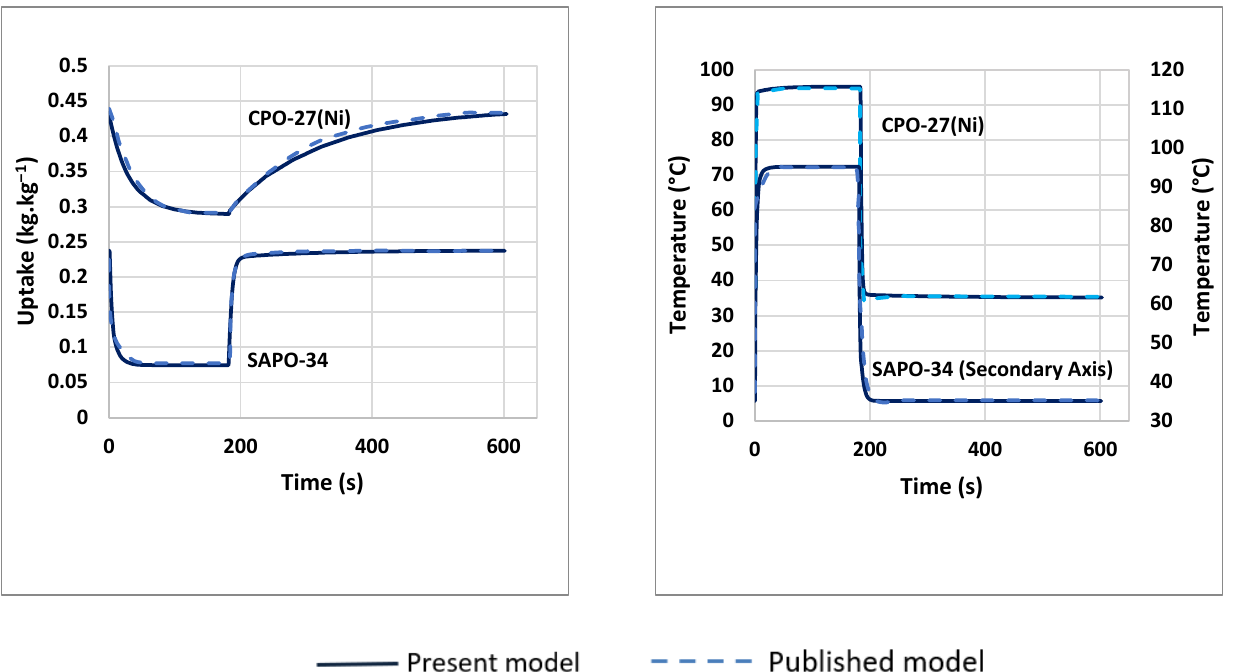
Figure 3. The uptake and temperature temporal variations for CPO-27(Ni) and SAPO-34 adsorbent materials obtained from the present model and reference [11].